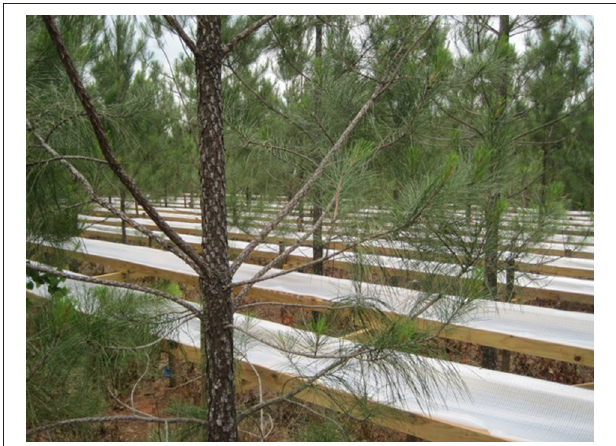
FIGURE 1 | Throughfall reduction structure covering 30% of the plot area with troughs to capture and funnel throughfall away from the plots. Taliaferro County, Georgia in 2012 when loblolly pines were 6 years old. Data collection period was May 2013 to August 2015.